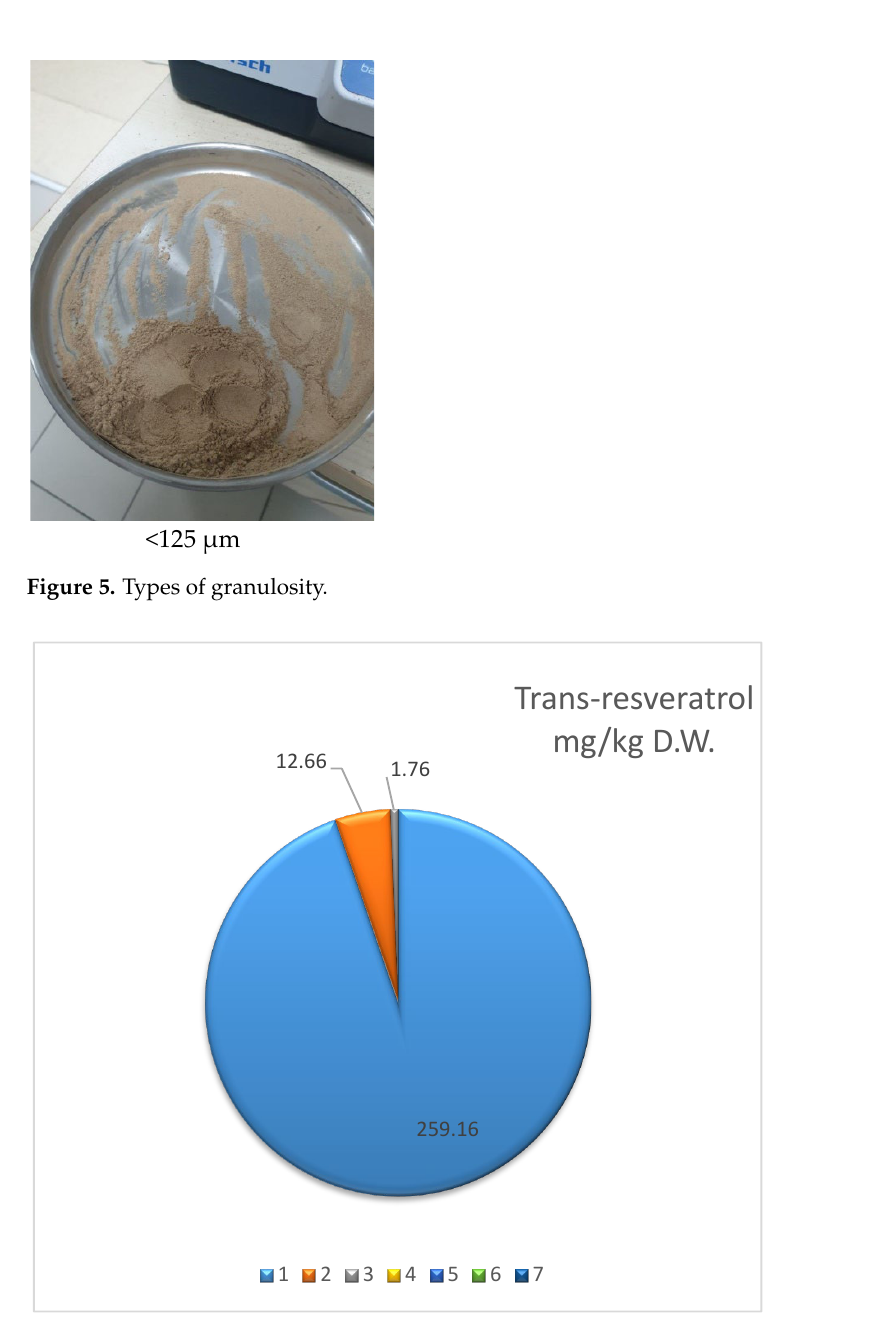
Figure 6. Extraction yield of resveratrol after 7 extractions on the same material. Table 2. Experimental and coded values according to Box–Behnken